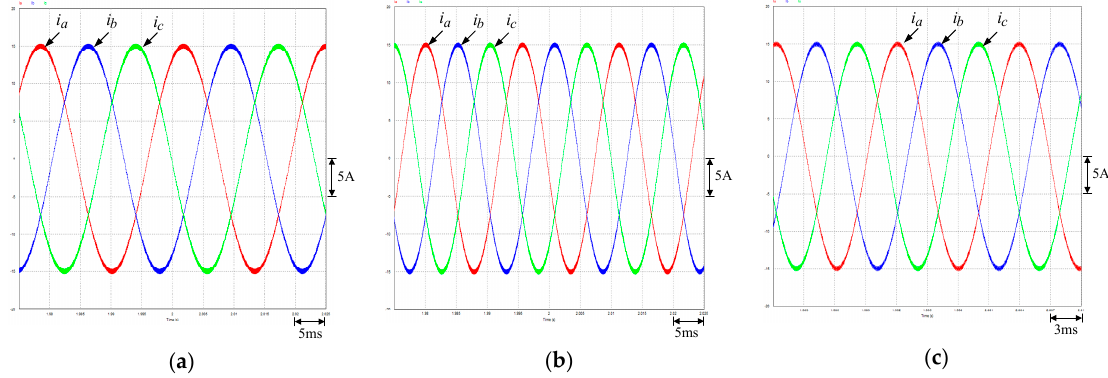
∗ ∗ = 0 A at di ff erent generator i =0 A at different q i =15 A and d d